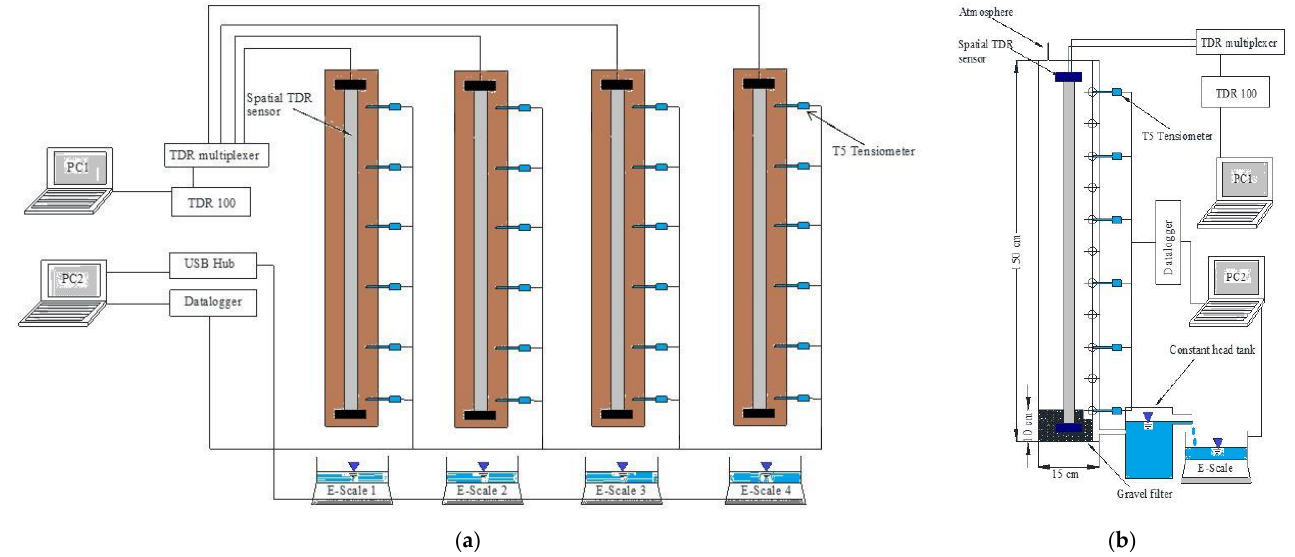
Figure 3. The schematic description of four Spatial TDR sensors — the flat ribbon cable (FRC), six high precision tensiometers (T5) and accumulative outflow logging scales and boundary conditions for the one-step in/outflow tests: ( a ) the overview of three data logging systems for four soil column tests; ( b ) the illustration of three data-logging systems for single soil column test of 150 cm in details.